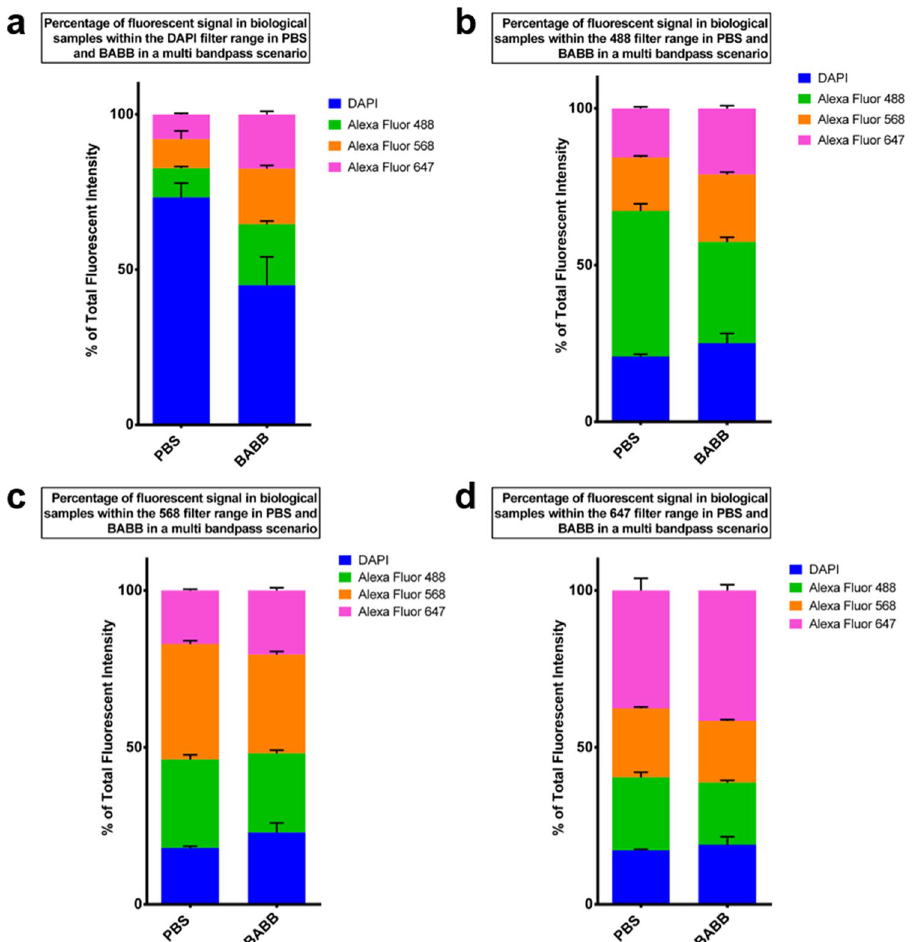
Figure 6. The BABB-induced spectral alterations exacerbate crosstalk in multi-bandpass excitation scenarios in biological samples. BABB clearing exacerbates crosstalk in biological samples in the DAPI ( a ) and the 488 Filter range ( b ) in multi bandpass scenarios, which is shown by the reduced percentages of total DAPI and Alexa Fluor 488 signal intensities for BABB in the respective filter ranges. The stacked graphs illustrate the total fluorescent signal distribution of DAPI (blue), Alexa Fluor 488 (green), Alexa Fluor 568 (orange), and Alexa Fluor 647 (magenta) in PBS (left) and BABB (right) in biological samples (MEFs). Data are grouped by emission filter wavelength: in the DAPI filter range ( a ), the 488 nm filter range ( b ), the 568 nm filter range ( c ), and the 647 nm filter range ( d ). Samples were immunostained with an anti-GAPDH primary antibody, and respective secondary antibodies, or DAPI, and measured with a high content imaging system. Error bars indicate standard deviation. n = 8 independent wells and measurements for each